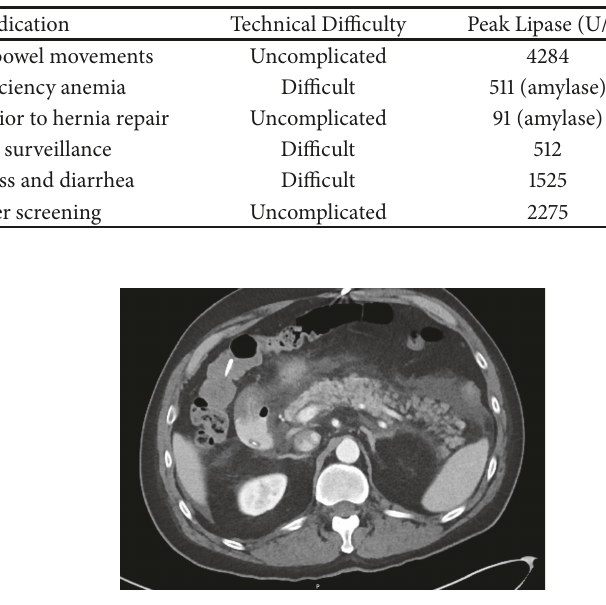
Figure 1: Abdominal contrast-enhanced computed tomography image. Thisimagerevealsdiffuseedematouschangesofthepancreas with surrounding inflammatory stranding and fluid consistent with acute